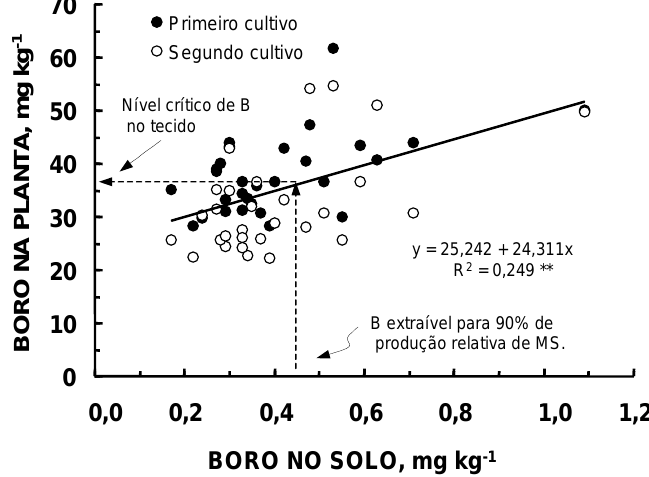
Figura 3. Teores de boro na matéria seca das plantas de girassol no tratamento sem boro, nos dois cultivos sucessivos sob condições de casa de vegetação, em função do teor de boro no solo extraído pela água quente, antes do primeiro cultivo, e estimativa do nível crítico de boro no tecido para 90% de produção relativa de matéria